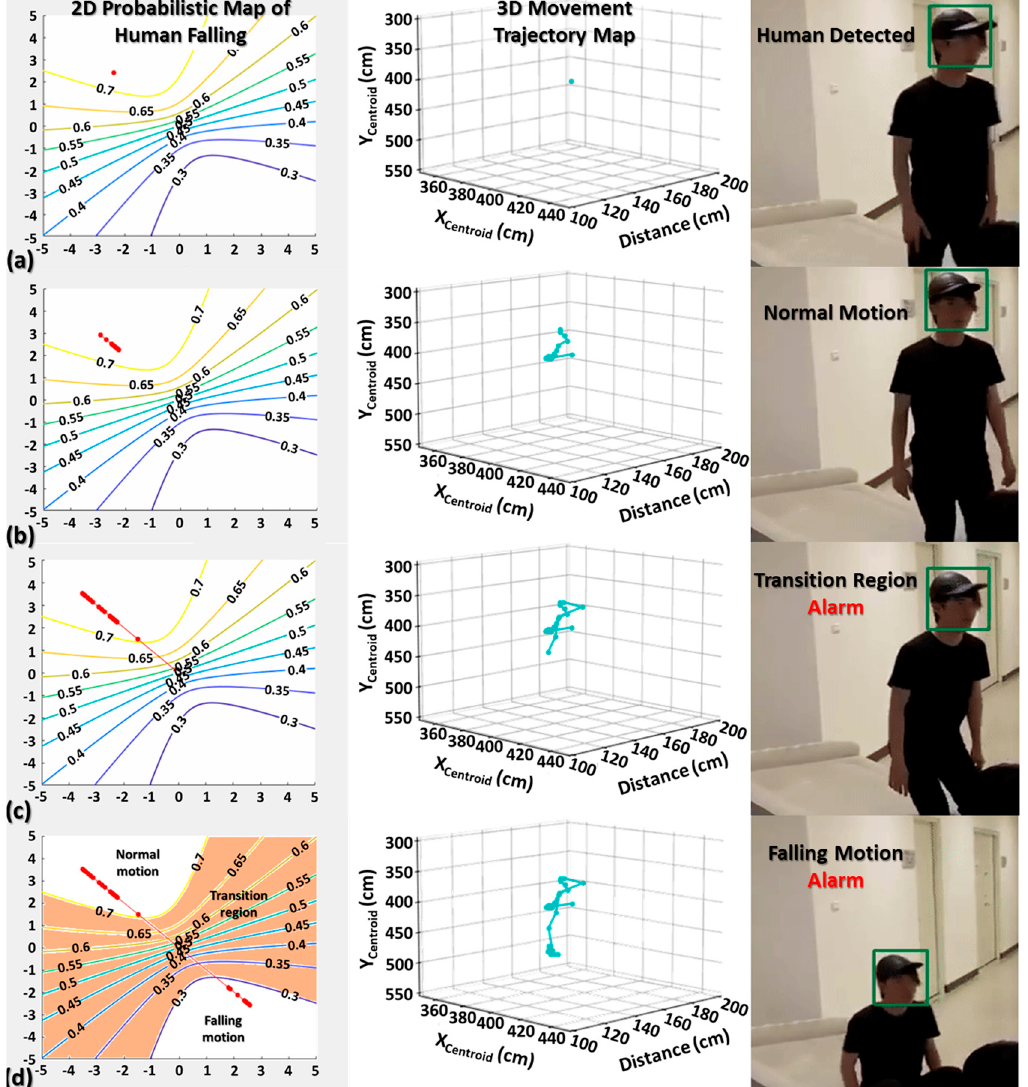
Figure 6. This figure illustrates the corresponding 2D probabilistic maps, 3D movement trajectory maps, and the detection- tracking results of ( a ) detecting a potential subject, ( b ) normal motion, ( c ) transition region, and ( d ) falling motion. Any motions making the data points appear in the transition region might trigger